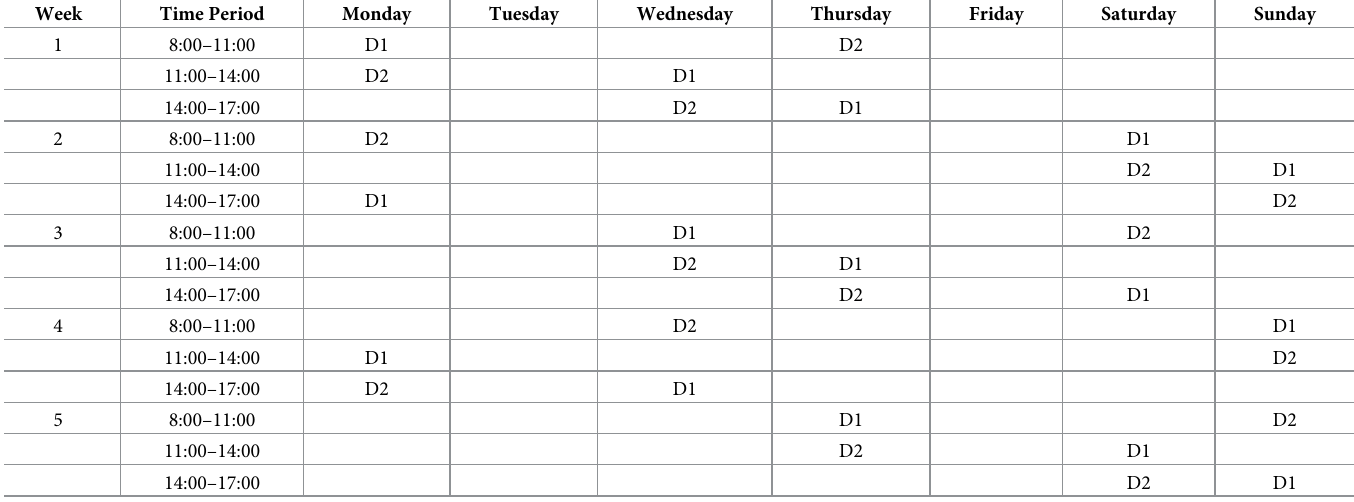
Table 1. Observation schedule for video taping focal animals.